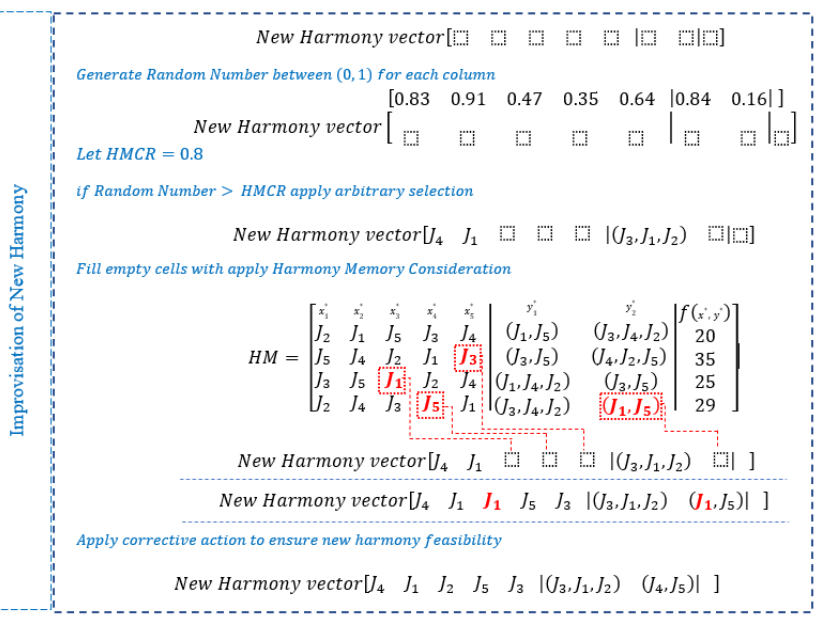
Figure 4. Example of improvisation of New Harmony.